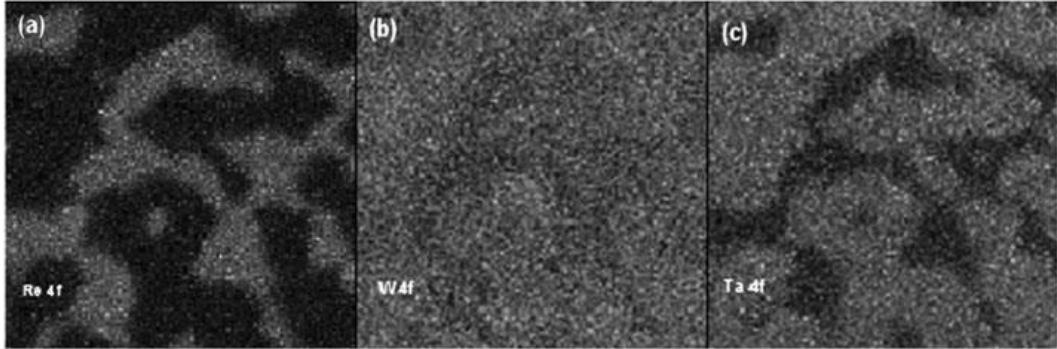
Figure 15. Re 4f ( a ), W 4f ( b ), and Ta 4f ( c ) chemical maps (5.1 × 5.1 µm 2 ) of the sample after the creep test [26].